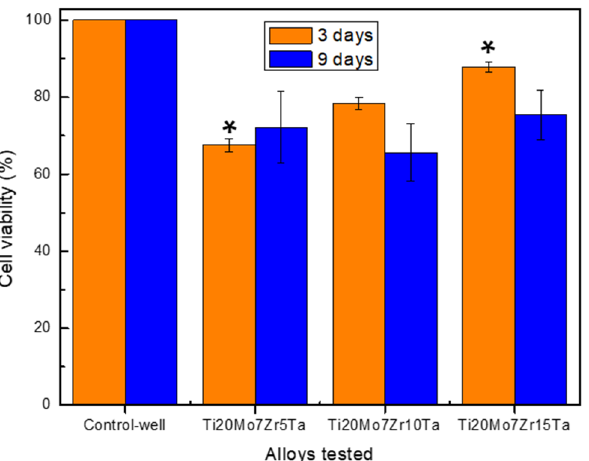
Figure 6. Cell viability profile (%; mean ± SD; n = 3) of HOS cells evaluated by MTT-assay: effect of Ti-Mo-Zr-Ta alloy samples on HOS cells’ viability after 3 and 9 days of culture (i.e., 3D and 9D). No significant differences on viability profile ( p > 0.05) between alloys samples after 9D. ( ∗ ) Significant differences ( p < 0.05) between them at 3D (see details in the